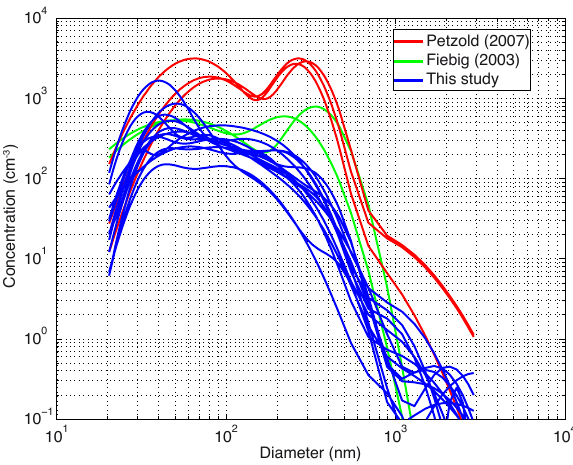
Fig. 8a. Fitted aerosol number size distributions of air masses origi- nating from North-American boreal forest fires measured over Cen- tral Europe (Petzold et al., 2007) in solid red line, Germany (Fiebig et al., 2003) in solid green line, and Greenland (this study) in solid blue line.